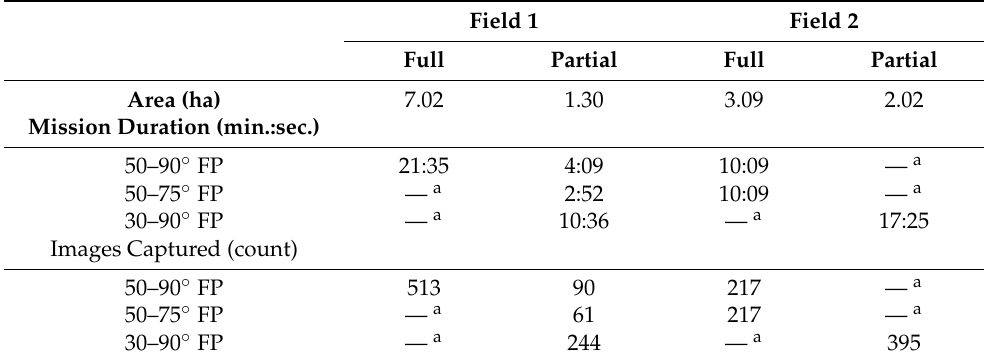
Table 2. Mission characteristics when operating with each set of flight parameters in each